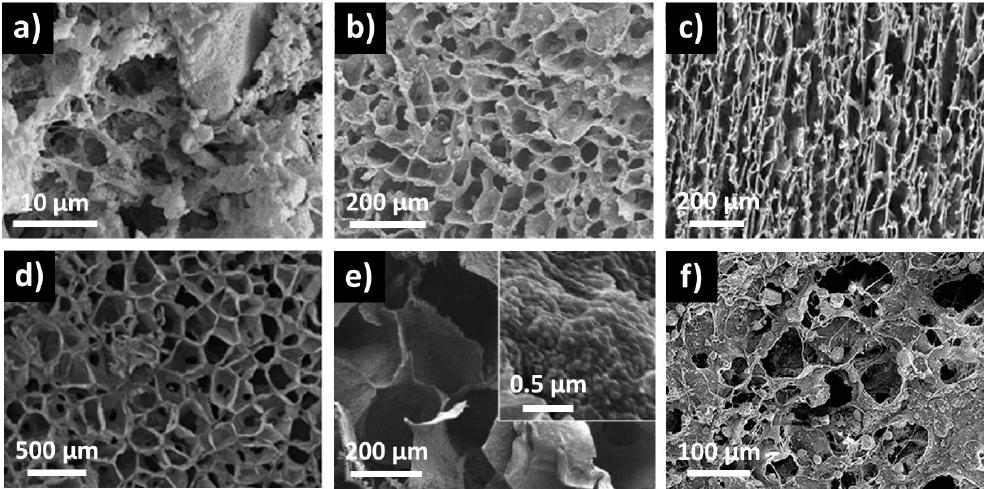
Figure 3. SEM micrographs of bioactive glass particles-polymer composites made by thermally-induced phase separation (TIPS), with poly( L -lactide), [20] ( a ) and [63] ( b ); poly(lactide- co -glycolide), [61] ( c ); chitosan-gelatin, [58] ( d ); gelatin, [59] ( e ) and collagen-phosphatidyserine, [62] ( f ) as polymer matrix. Figure adapted with permission from [20,58,61–63] ©Elsevier, [59] ©American chemical Society.